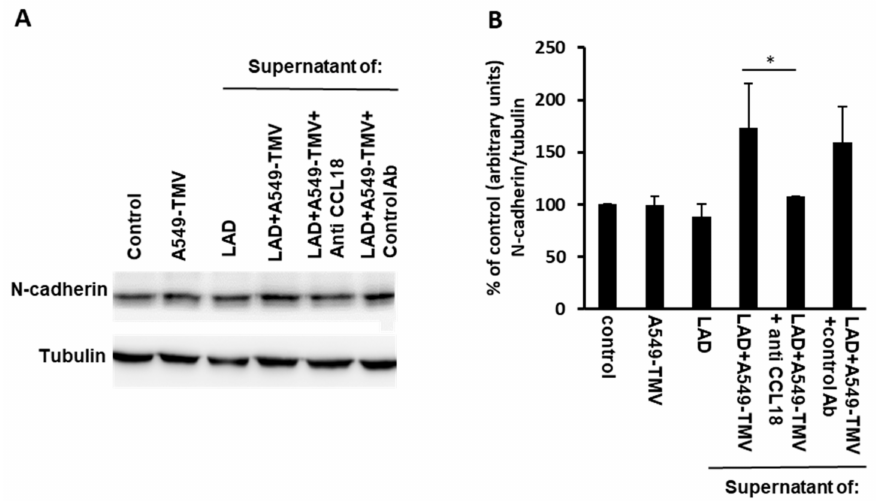
Figure 4. CCL18 released from NSCLC-TMV-stimulated mast cells enhanced EndMT in HUVECs. ( A ) HUVECs were incubated for 24 h as indicated. N-cadherin levels were analyzed by immunoblot- ting. ( B ) Densitometry analysis of N-cadherin. These results are representative of three independent experiments. Data are presented as mean ± SE (* p <